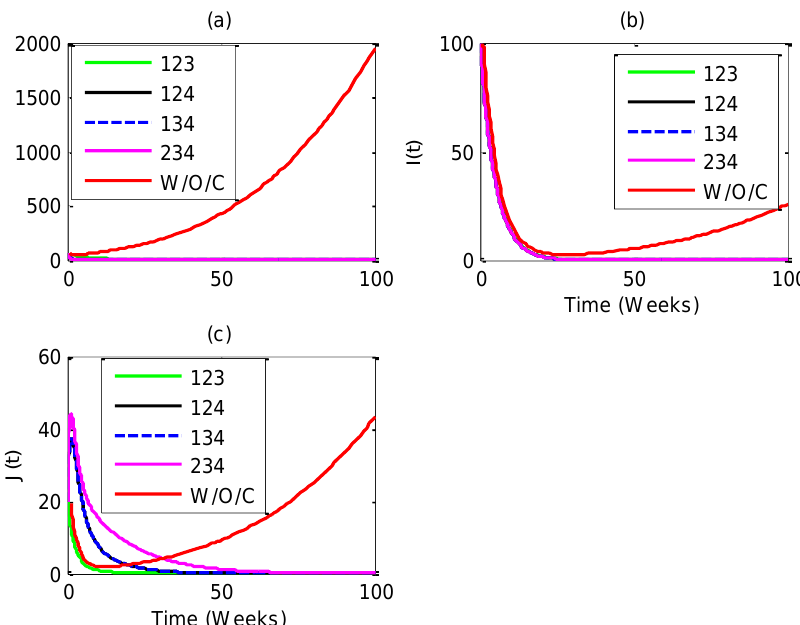
Figure 5. The population dynamics of (a) infected persons in the prodromal stage, 𝑃(𝑡) , (b) infected persons in the rash stage, 𝐼(𝑡) , (c) Isolated persons, 𝐽(𝑡) when triple controls are implemented together. Here, the numbers 1,2, 3, 𝑎𝑛𝑑 4 , are subscripts of the control functions, 𝑢 while W/O/C means “Without Control”. , 𝑢 , 𝑢 , 𝑢 1 2 3 4